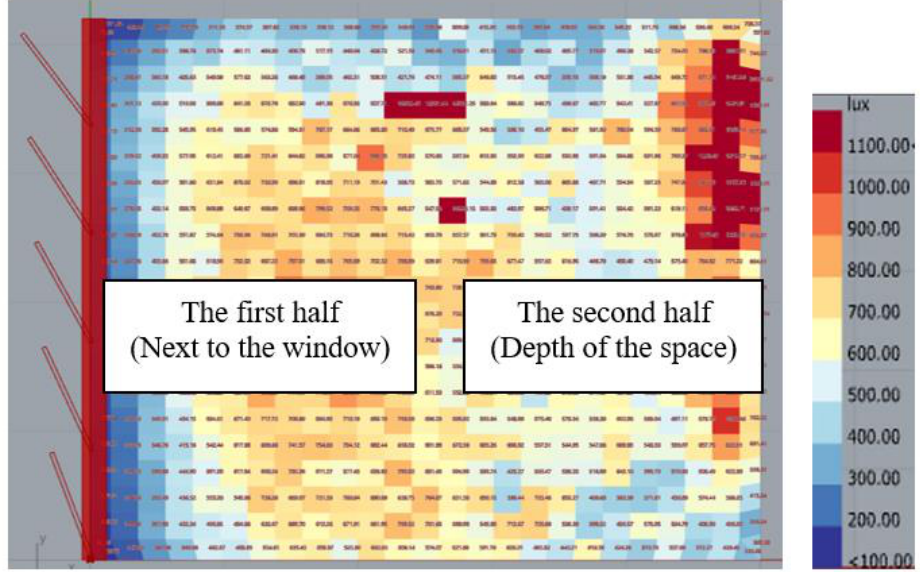
Figure 5. Illuminance value at the deep-plan area is higher than the area near the window, which can potentially cause glare.